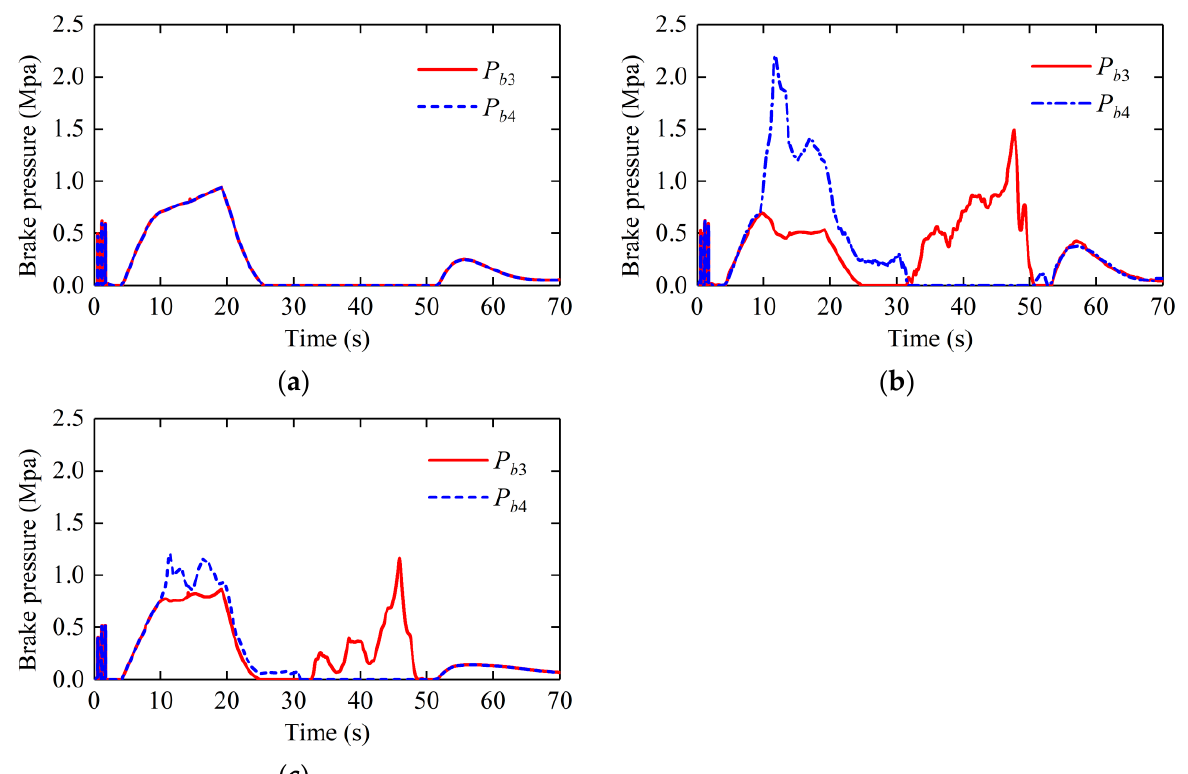
Figure 19. Brake pressure on wheels: ( a ) brake pressure with ACC; ( b ) brake pressure with ACC&DYC; ( c ) brake pressure with proposed control.